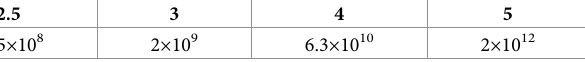
Table 1. Energy released during earthquakes of different magnitudes in the form of seismic waves. Magnitude